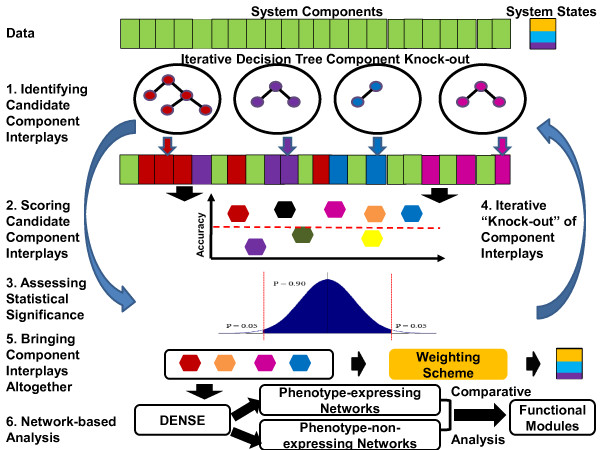
The overview of Spice’s key steps.